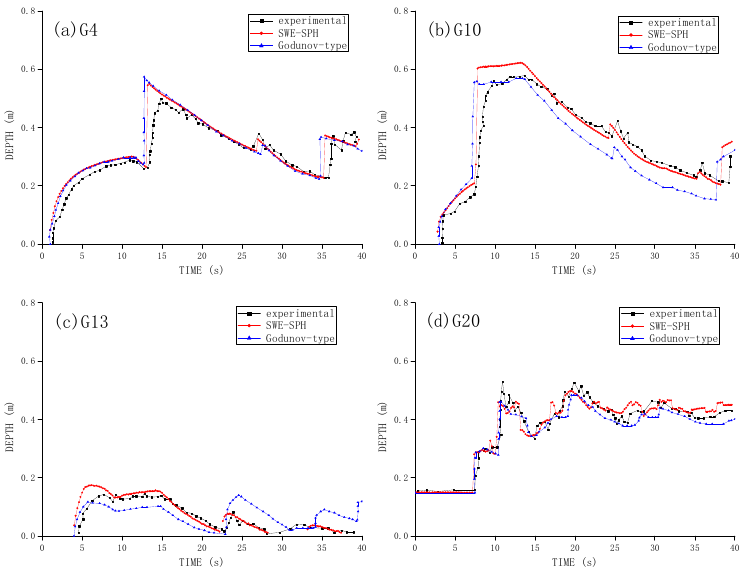
Figure 9. Time histories of dam break flow surface profile at gauging points between Godunov cut-cell [23] and SWE-SPHysics results and experimental data [19] at: ( a ) G4; ( b ) G10; ( c ) G13; and ( d ) G20.